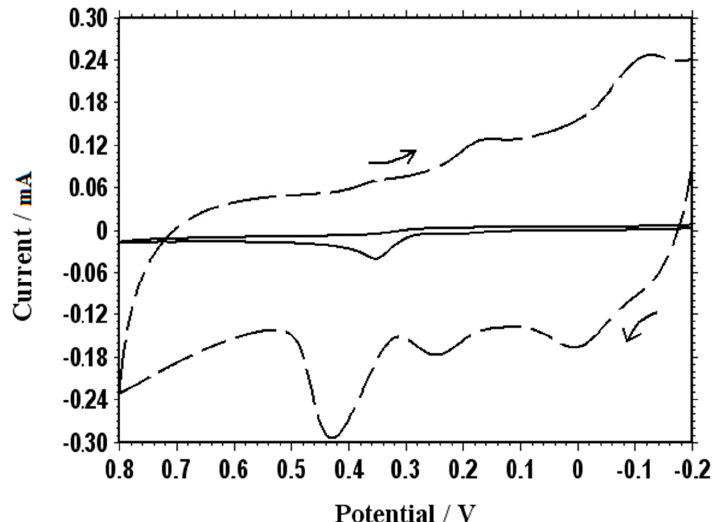
Figure 10. The cyclic voltammogram for simultaneous determination of 1 × 10 − 4 M DA and 1 × 10 − 3 M uric acid (UA) in 0.1 M PBS (pH 7.0) at a bare electrode (solid line) and a PMCPE (dashed line). Scan rate: 100 mV ∙ s − 1 .